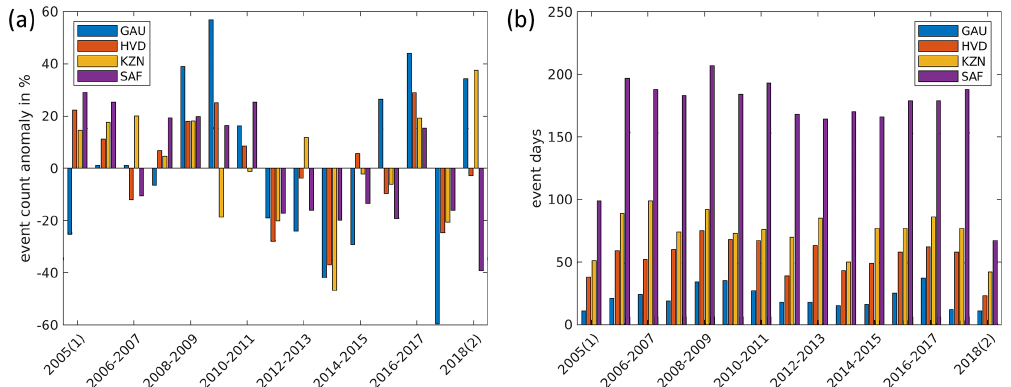
Figure 13. Time series of event count anomaly: (a) deviation of the annual sum from the 14-year mean and (b) event days per year (July– June) for the regions Gauteng (GAU, regional annual mean event count 35), the Highveld (HVD, 152), KwaZulu-Natal (KZN, 181), and South Africa (SAF, 1259). The July–June period is considered more appropriate as the austral summer season is not split among years. For the 2004/2005 period, only events in 2005 are covered; likewise 2018/2019 covers only the last 6 months of 2018. When computing the event count anomalies for these years, the overall repartition of events to half years was taken into